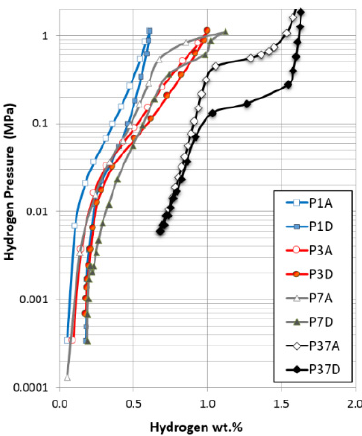
Figure 1. Pressure-concentration-temperature (PCT) isotherms measured at 30 °C for Alloys P1, P3, P7 and P37.